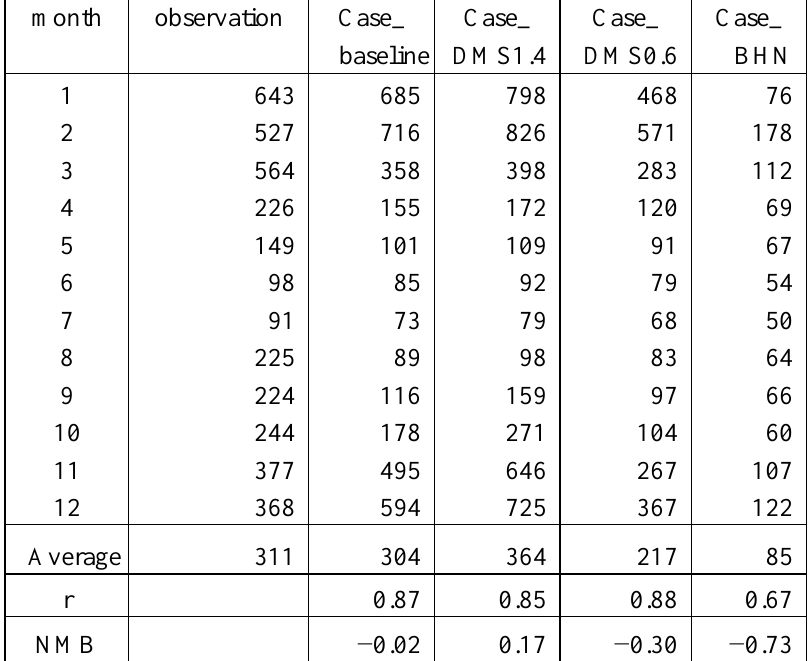
Table 1. A comparison of observed and simulated monthly mean CN10 values for different months of 2006 at the Neumayer station. Pearson correlation coefficient (r) and normalized mean bias (NMB) for four different modeling cases are also given.